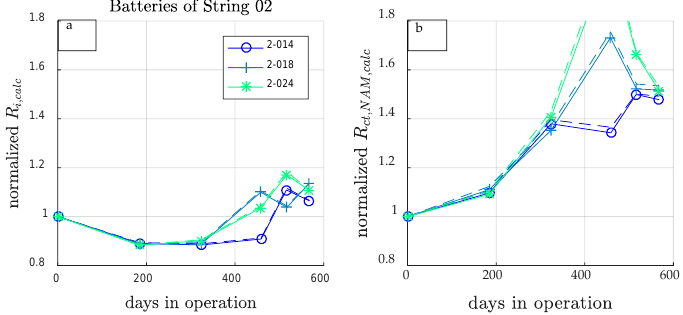
Figure 9. Change of the calculated parameters based on two impedance measurements (100 Hz and 1 Hz) for the batteries of string 2. Solid lines are R (Z) and dashed lines |Z|. ( a ) normalized change of R i,calc based on values measured @100 Hz. ( b ) normalized change of R ct,NAM,calc, which is the delta of impedances @100 Hz and 1 Hz. Table 6. Summary of absolute (abs.) and normalized (norm.) resistance values for R i and R ct either fitted from the impedance spectra (fitted) or calculated based on single-frequency measurements @100 Hz and 1 Hz. n.y.f. = not yet fitted.